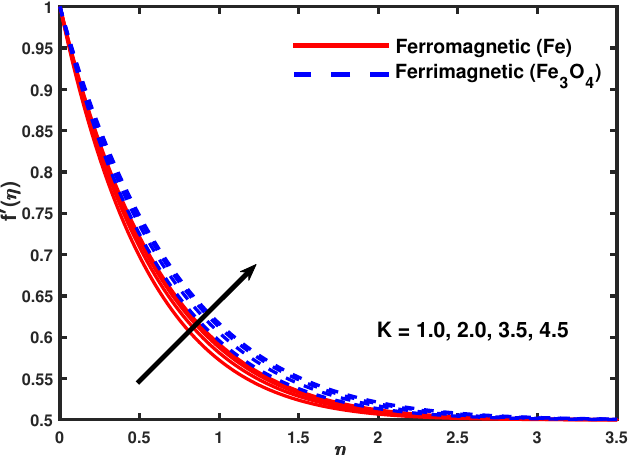
Figure 8. Impact of magnetic nano-particles and micro-rotation parameter ( K ) on the velocity profile f (cid:48) ( η ) .